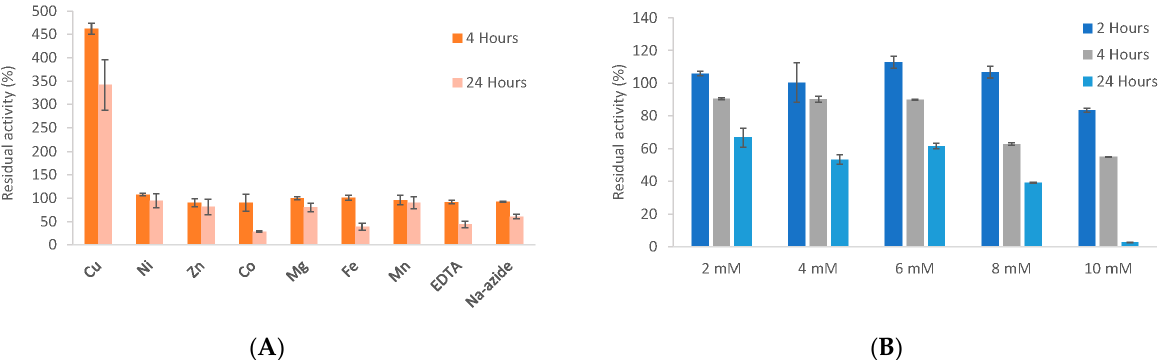
Figure 4. Enzyme stability in the presence of metals, inhibitors and H 2 O 2 . ( A ) Effect of 10 mM of Cu, Ni, Zn, Co, Mg, Fe, Mn, EDTA and sodium azide on the enzymatic activity of Tr LOx after incubation for 4 (dark orange) and 24 h (light orange); ( B ) Enzyme stability in the presence of increasing concentrations of hydrogen peroxide over an incubation period of 2, 4 and 24 h. Activities were calculated as a relative percentage of the activity in the absence of any molecule and reported as mean. Standard deviations are presented by error bars.